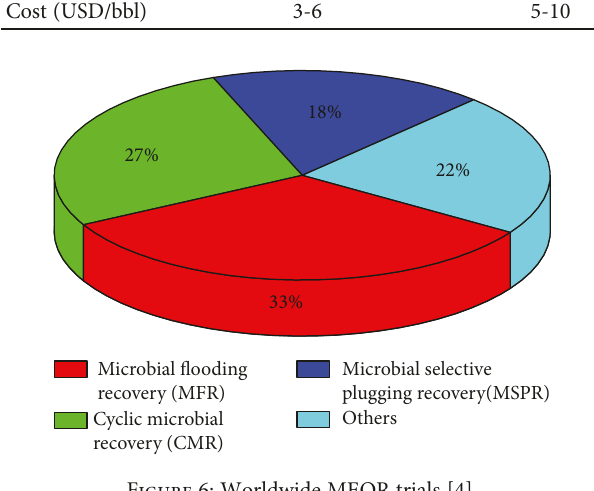
Figure 6: Worldwide MEOR trials [4].